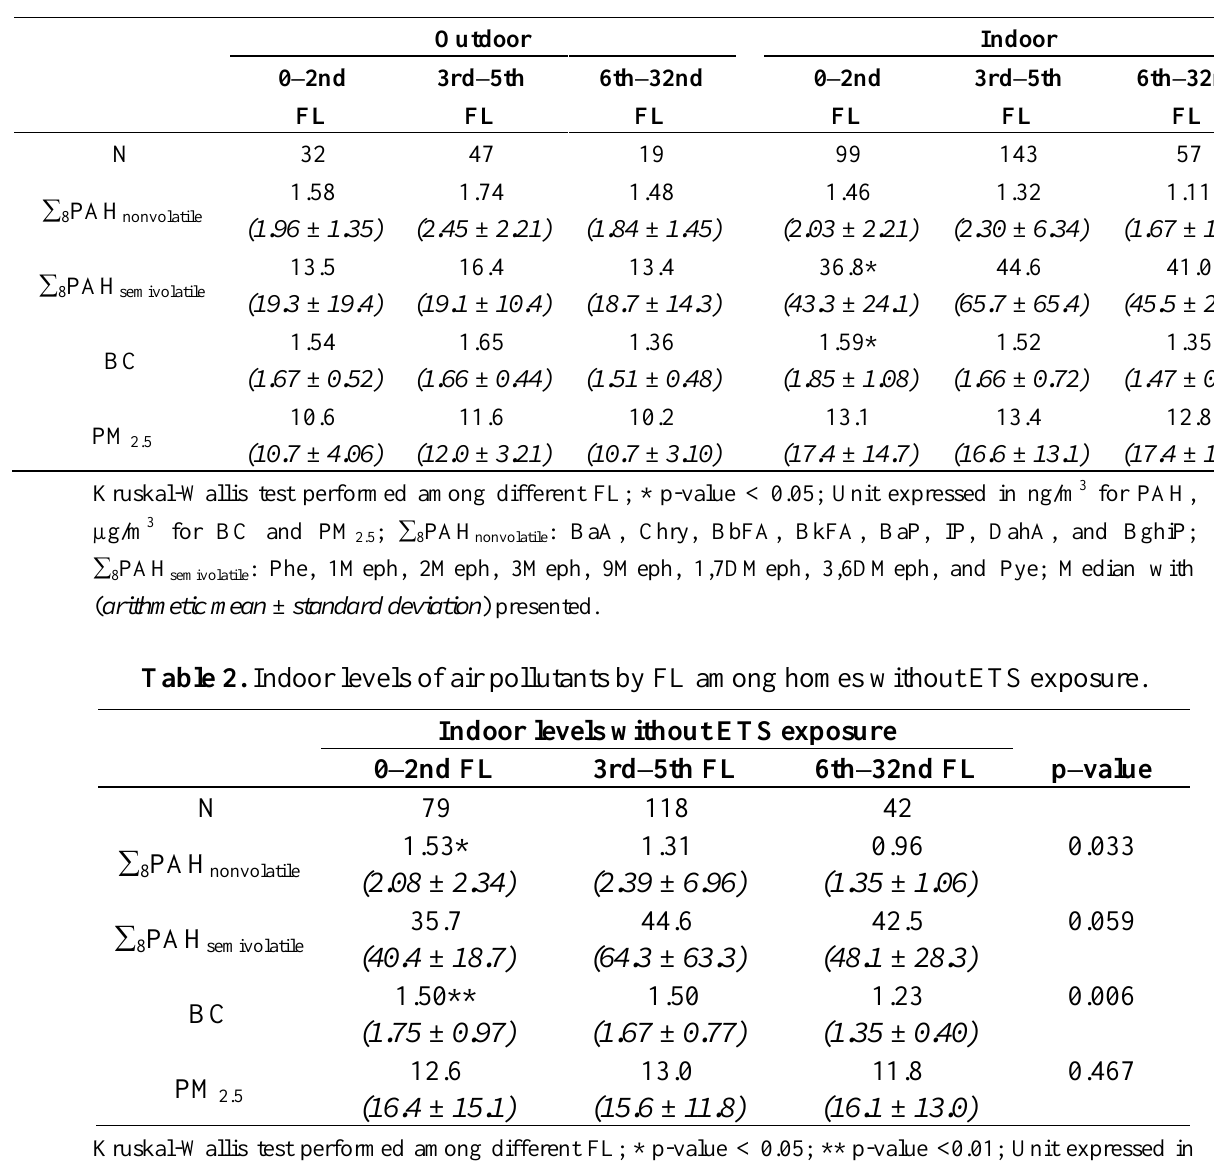
Table 1. Residential outdoor and indoor levels of air pollutants measured by FL.